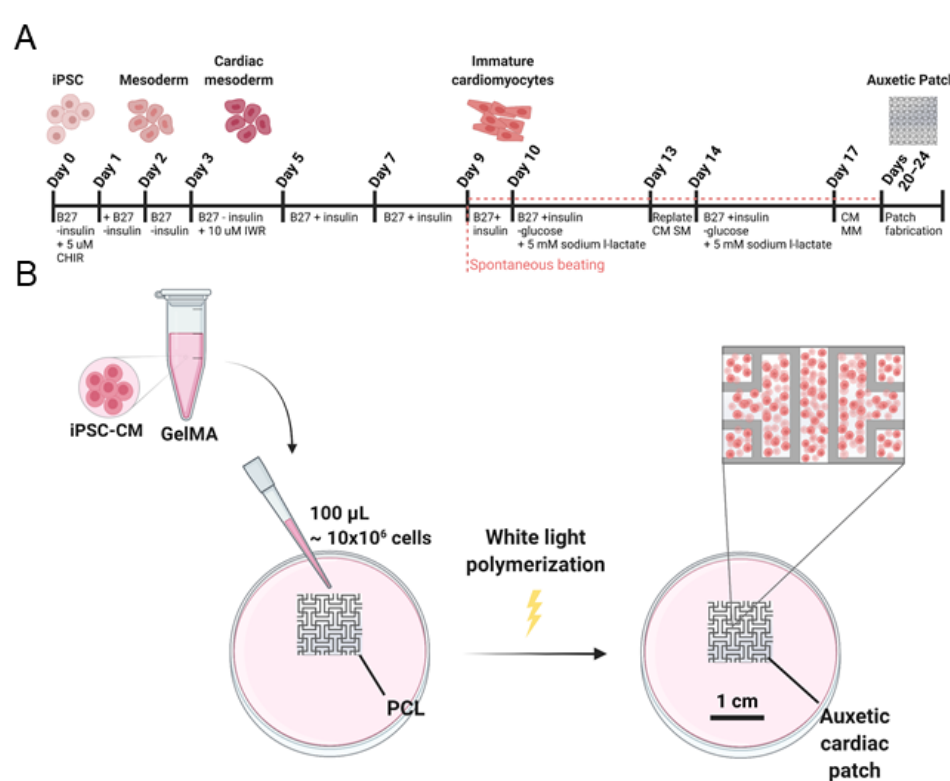
Figure 3. Cardiomyocyte incorporation into the auxetic patch. ( A ) Schematic timeline of Wnt-modulated cardiac differentiation and subsequent glucose starvation; ( B ) Fabrication process of auxetic cardiac patch composed of PCL and GelMA.